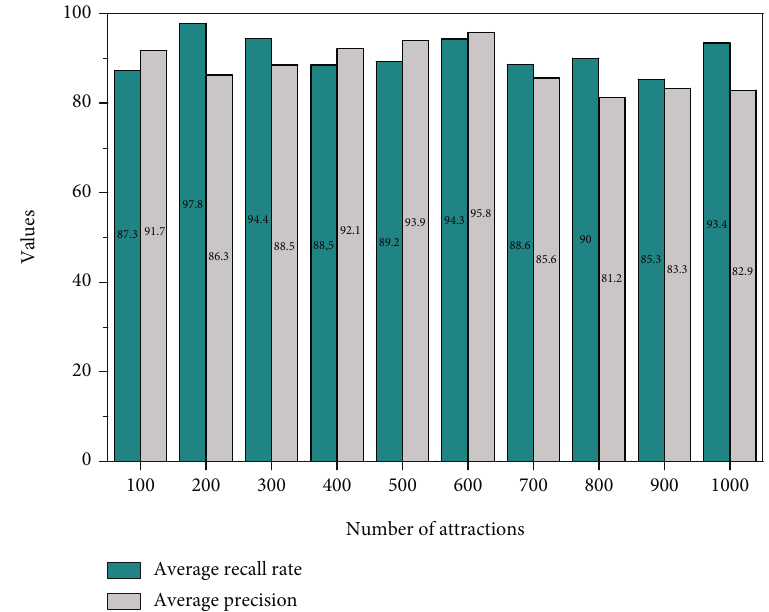
Figure 6: Average accuracy rate and average completeness rate.